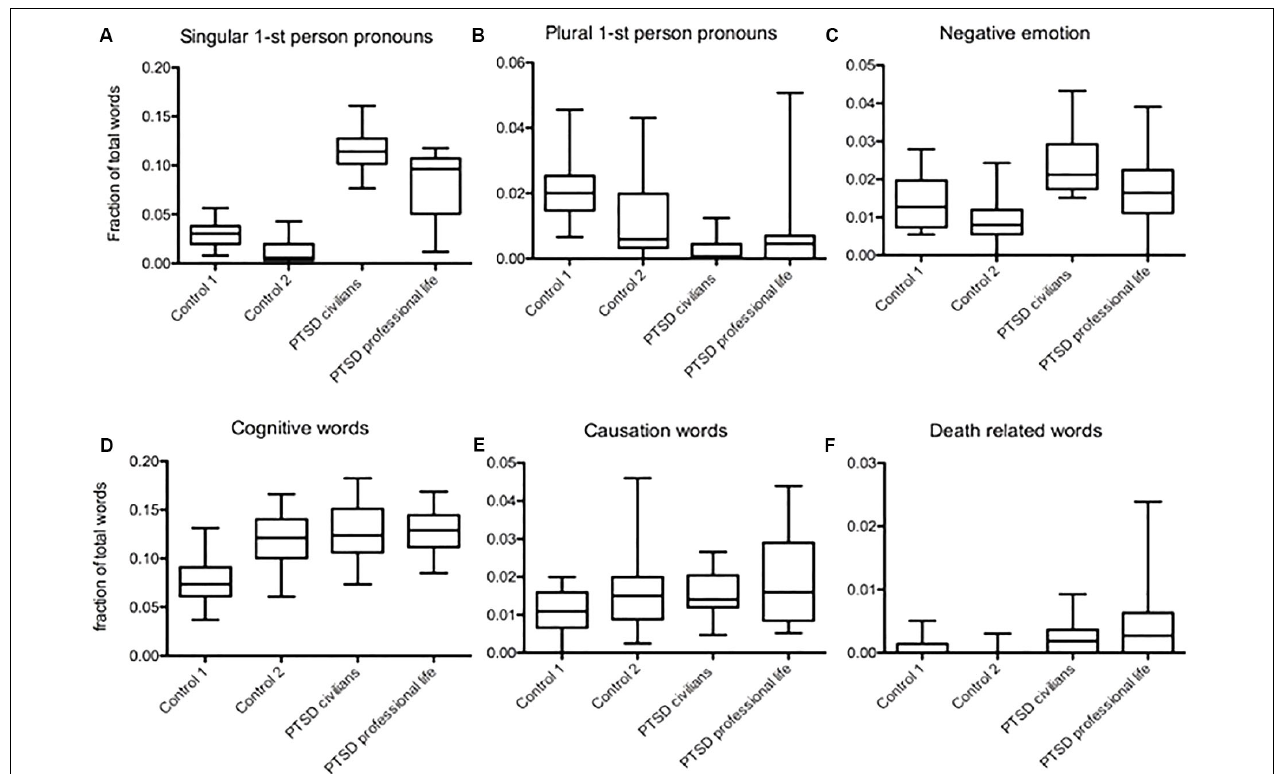
FIGURE 2 | Word patterns in texts from people PTSD sufferers whose trauma occurred in a work setting compared to personal life related trauma. (A) Higher frequency of singular first-person pronouns in both PTSD groups compared to both controls, the highest found in civilians with PTSD (Mdiff = 0.086, Mdiff = 0.052, p < 0.001; Mdiff = 0.102, Mdiff = 0.0683, p < 0.001). (B) Lower frequency in plural first-person pronouns in both PTSD groups compared to control 1, but compared to control 2 only PTSD in civilians show a significant difference (Mdiff = 0.019, Mdiff = 0.015, p < 0.001; Mdiff = 0.0103, p < 0.01, Mdiff = 0.0068, p > 0.05). (C) Both PTSD groups had a higher frequency of negative emotion words but only compared to control 2 (Mdiff = 0.0149, p < 0.001; Mdiff = 0.0086, p < 0.05). Compared to control 1 only civilians showed a difference in negative emotion word usage (Mdiff = 0.0097, p < 0.05). (D) Higher usage frequency of cognitive words in both PTSD groups compared to control 1 (Mdiff = 0.049, p < 0.001; Mdiff = 0.0503, p < 0.001) but not to control 2 ( p > 0.05). (E) There was no significant difference in causation word usage between the two PTSD groups and/or controls ( p > 0.05). (F) Death related word occurrence was higher in the professional life related trauma group than in both controls, the difference being greater comparing to control 2 (Mdiff = 0.0033, p < 0.05; Mdiff = 0.004, p <